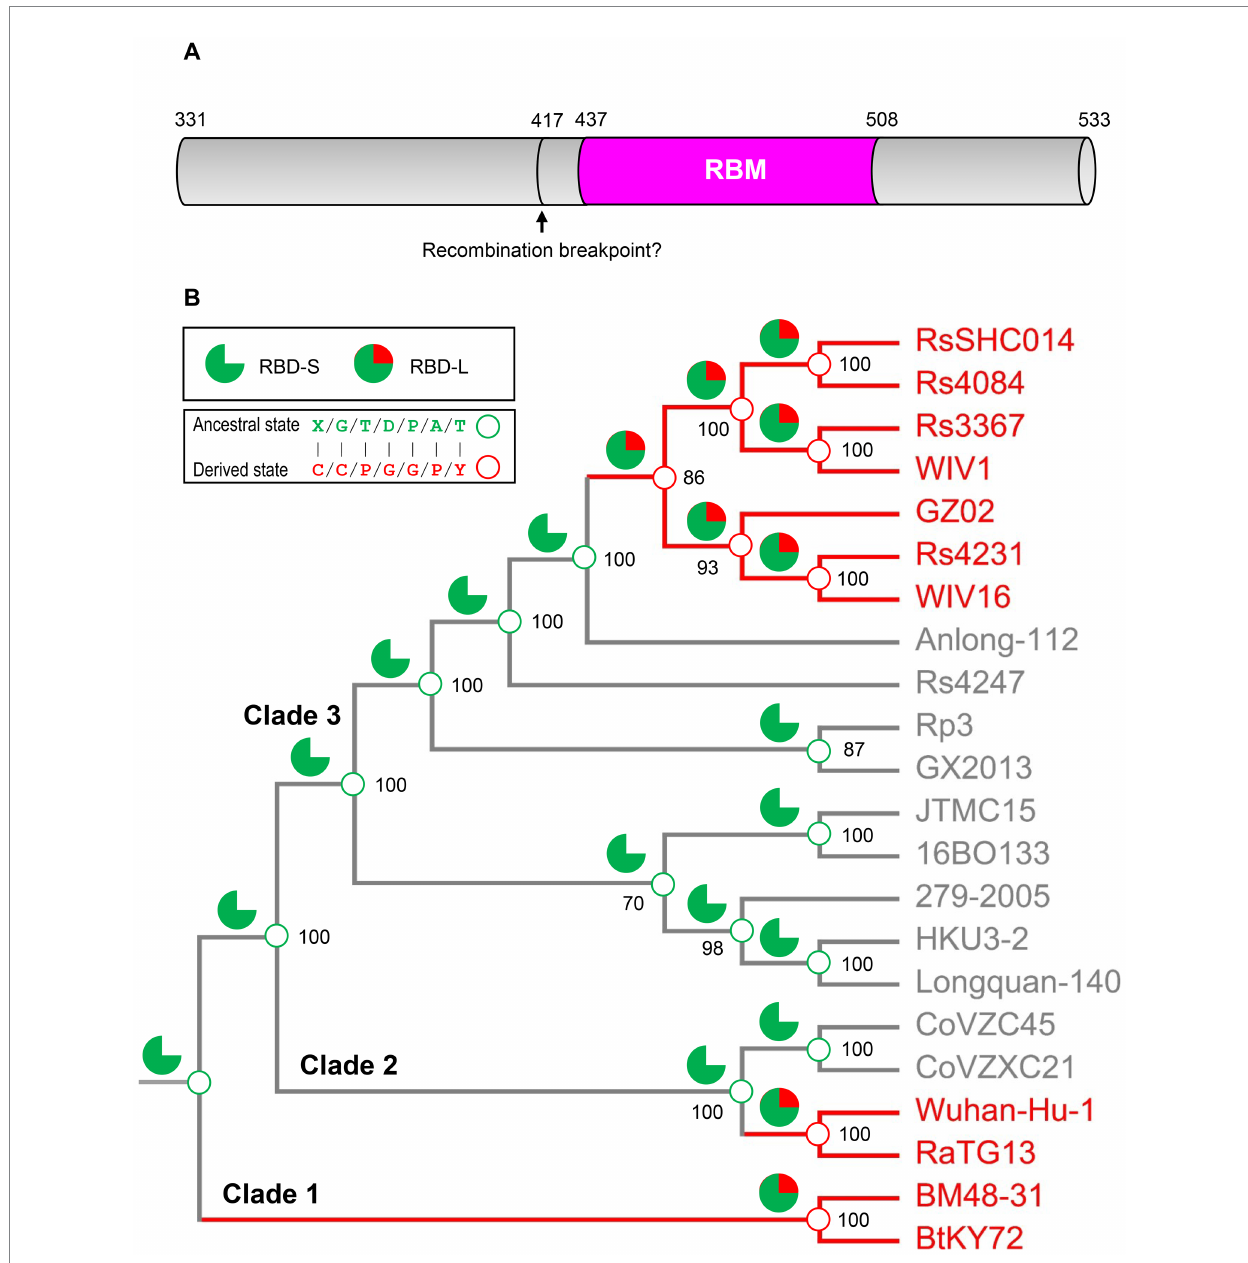
FIGURE 6 Ancestral sequence reconstruction for elucidating the histories of the insertions and point mutations proposed by parallel evolution. (A) Schematic diagram illustrating the structural organization of RBDs, in which the pink region corresponding to the RBM was used to reconstruct ancestral sequences. The putative recombination breakpoint was denoted by an arrow (Starr et al., 2022). Residues were numbered according to the SARS- CoV-2 spike. (B) The projection of the ancestral traits including the insertions and point mutations proposed by parallel evolution onto the genome phylogeny. Green sector graphs represent RBD-S without an insertion and green and red sector graphs represent RBD-L with the insertion. Green and red circles represent an ancestral state and a derived state,